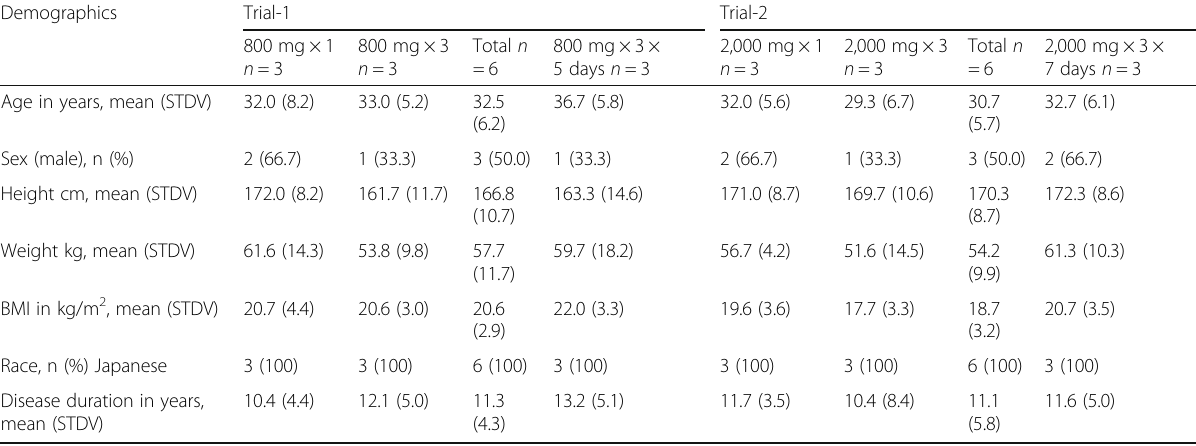
Table 1 Subject demographics and baseline